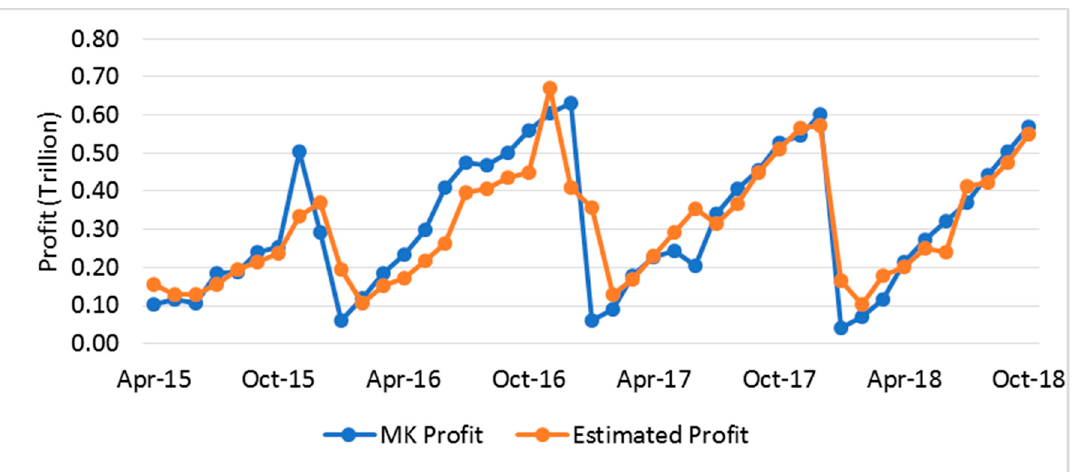
Figure 7. MK profit and estimated profit of Bank C.